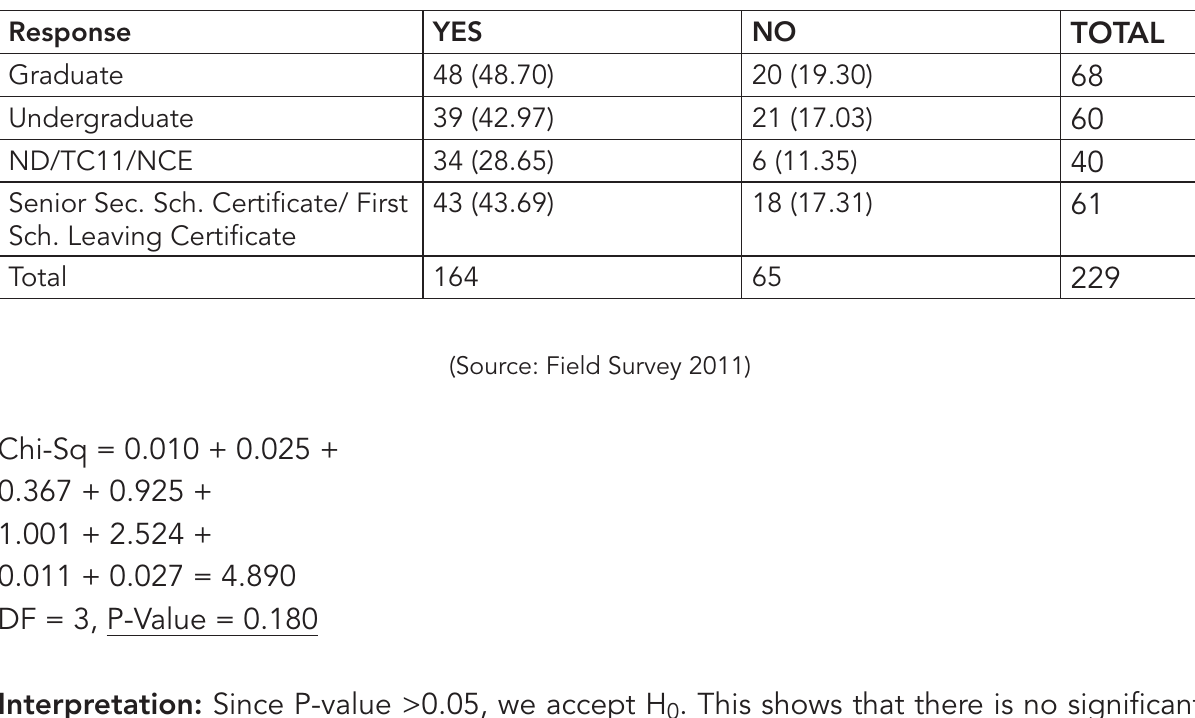
Table 2: Affordability of service